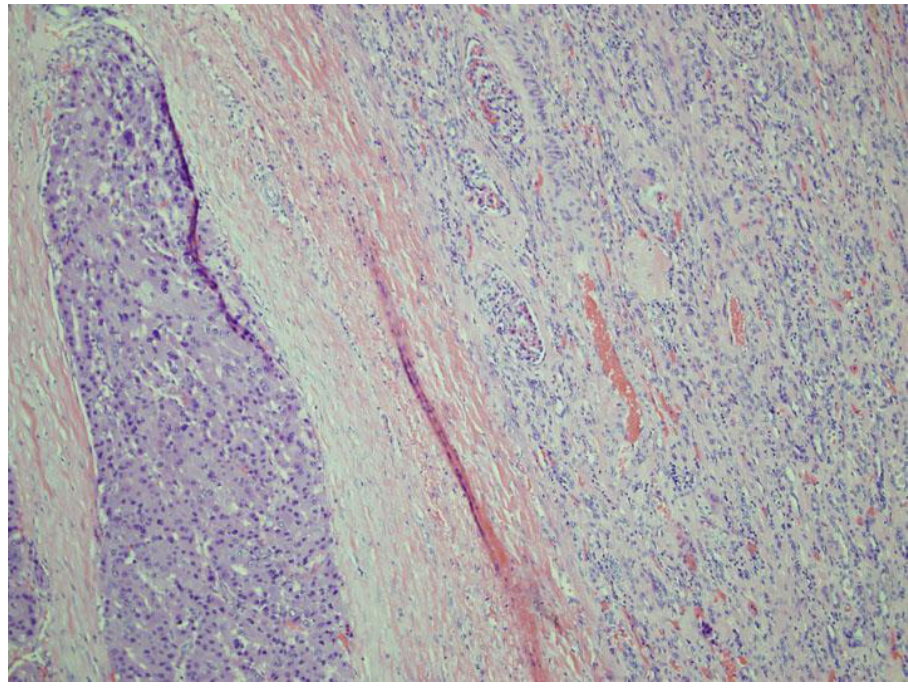
FIGURE 4. Histologic section showing renal parenchyma on the right and HCC on the left.